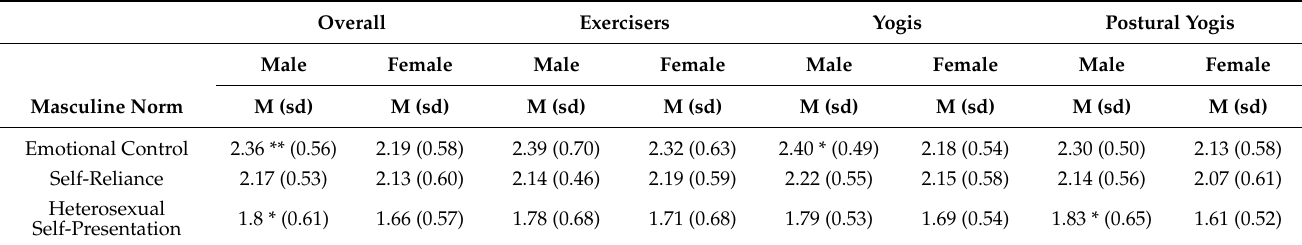
Table 3. Descriptive statistics of Conformity to Masculine Norms subscales by gender and participant